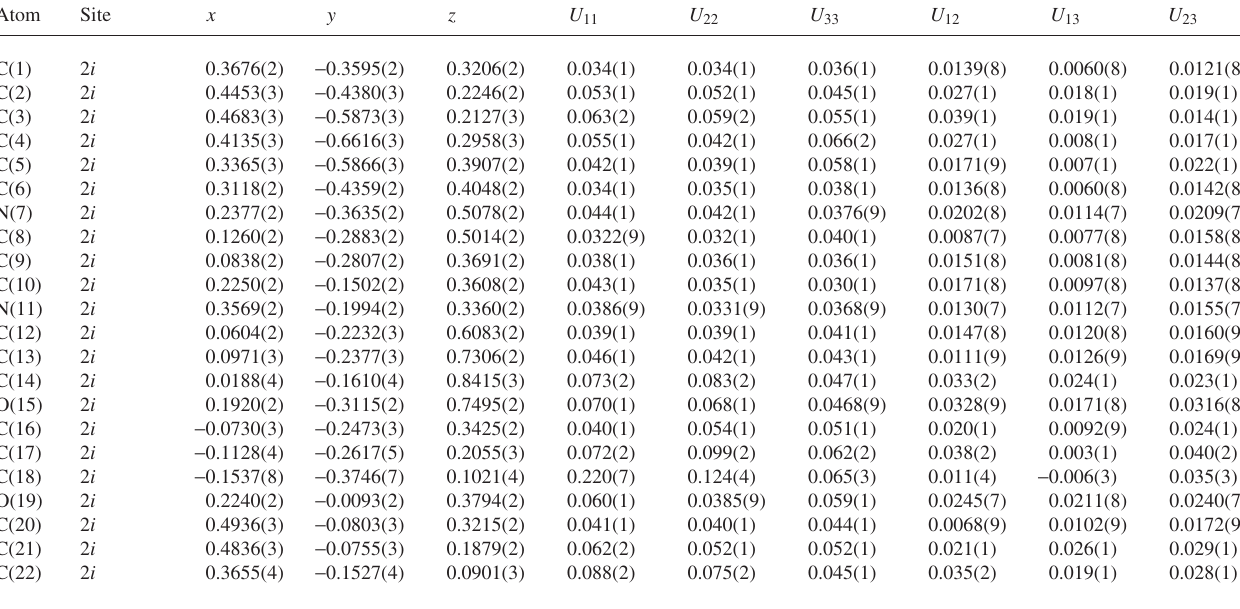
Table 3. Atomic coordinates and displacement parameters (in Å 2 )